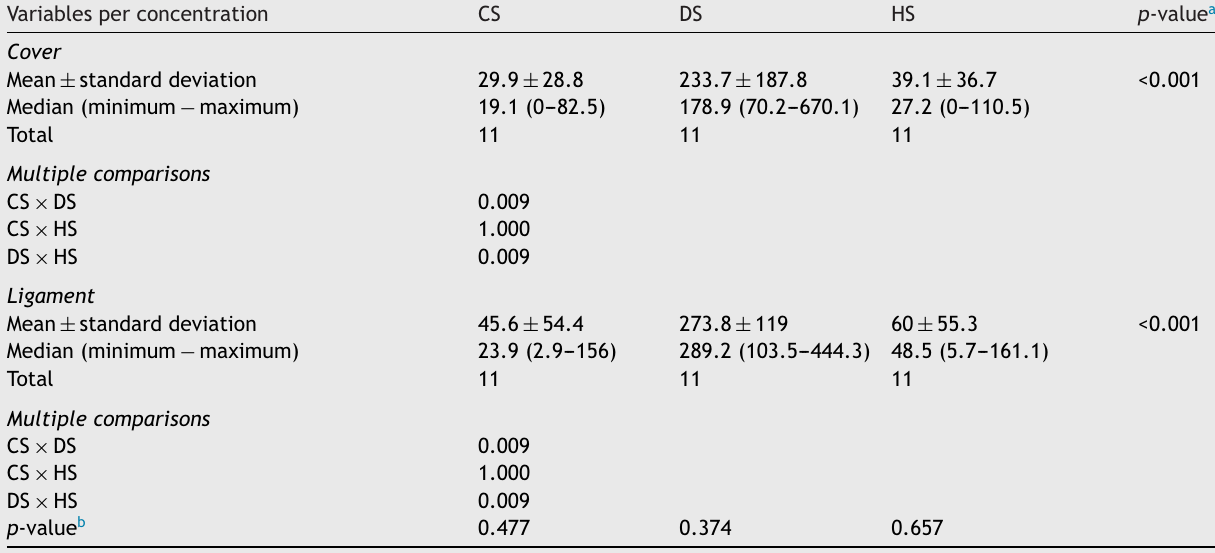
Table 4 GAG concentration (CS, DS e HS) in the different layers of the vocal fold. Variables per concentration CS Cover